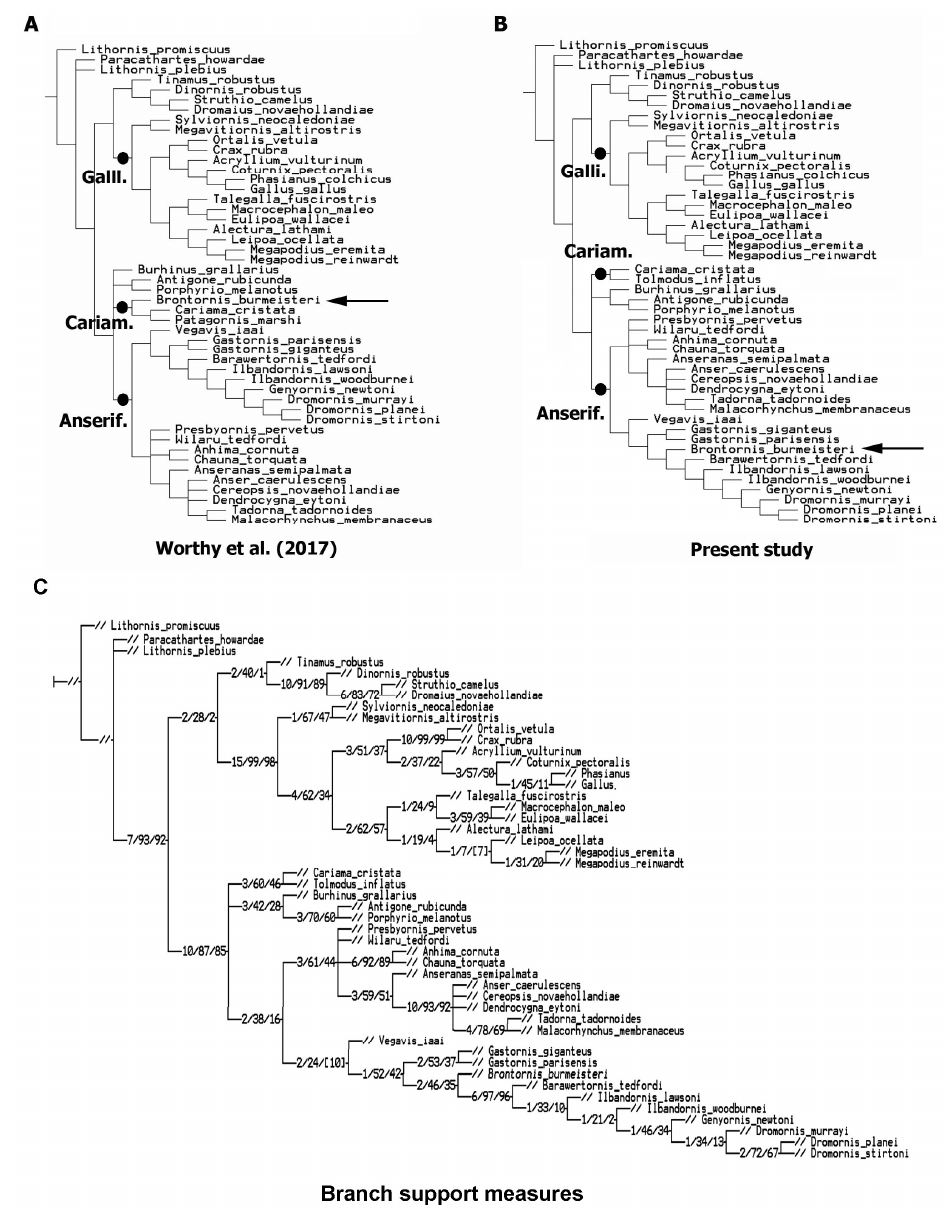
Figure 1. Phylogenetic analysis depicting the position of Brontornis burmeisteri . ( A ) hypothesis proposed by Worthy et al. [24]; ( B ) hypothesis proposed in the present study; ( C ) consensus tree showing branch support measures. From left to right: Bremer support, absolute bootstrap frequency, and GC bootstrap frequency. The arrow indicates the position of Brontornis . Abbreviations. Anserif., Anseriformes; Cariam., Cariamiformes; Galli., Galliformes.